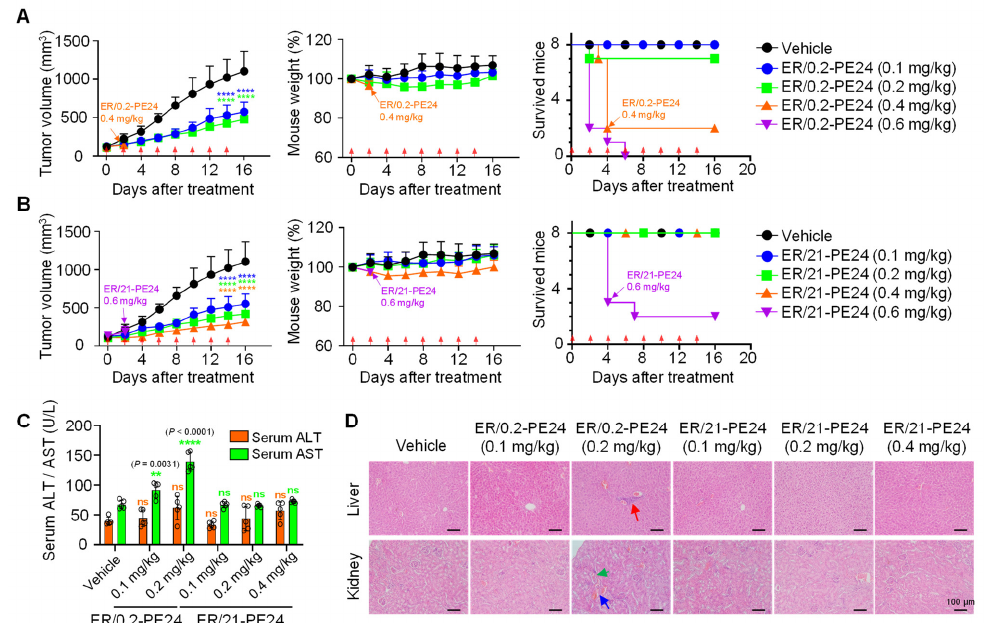
Figure 4. ER/21-PE24 with an intermediate EGFR affinity has a much broader therapeutic window than ER/0.2-PE24 with the highest EGFR affinity. ( A , B ) Tumor growth ( left ), mouse body weight ( middle ), and survival curves ( right ), as measured during treatment of A431 tumor-bearing mice (TBM) initiated at the tumor volume of ~100 to 120 mm 3 with either i.v. injection of ER/0.2-PE24 ( A ) or ER/21-PE24 ( B ) at a dose of 0.1, 0.2, 0.4, and 0.6 mg/kg every other day (indicated by red arrows). The vehicle indicates PBS buffer as control. If TBM death occurs in more than 2 TBMs from each regimen, treatment was stopped, as indicated by the arrow in the panel. Symbols and error bars represent the mean ± SEM. Data were pooled from two independent experiments with four mice per group. ( C ) Serum levels of liver enzymes (ALT and AST) were measured in each group of TBM at the endpoint of treatment. Each symbol represents the value obtained from individual mice, and the bar graphs present the mean ± SD ( n = 5 per group). In ( A – C ), **, p < 0.01; ****, p < 0.0001 versus the vehicle-treated TBM. ns, not significant. ( D ) Hematoxylin and eosin (H&E) staining of representative tissue sections from the liver and kidney of each group of TBM was performed at the end of treatment. Abnormal histological features suggestive of hepatic toxicity or renal toxicity are indicated using arrows of different colors [Inflammatory cell infiltration (red), tubular necrosis (green), interstitial hemorrhage (blue)]. Magnification, ×200; scale bar, 100 μm. In case of ER/21-PE24, mortality was observed in more than 50% of TBM after two doses at 0.6 mpk (Figure 4B and Table 3). However, the lower doses of 0.4, 0.2, and 0.1 Table 3. In vivo toxicity of ER-PE24 ITs measured in A431 tumor-bearing mice.